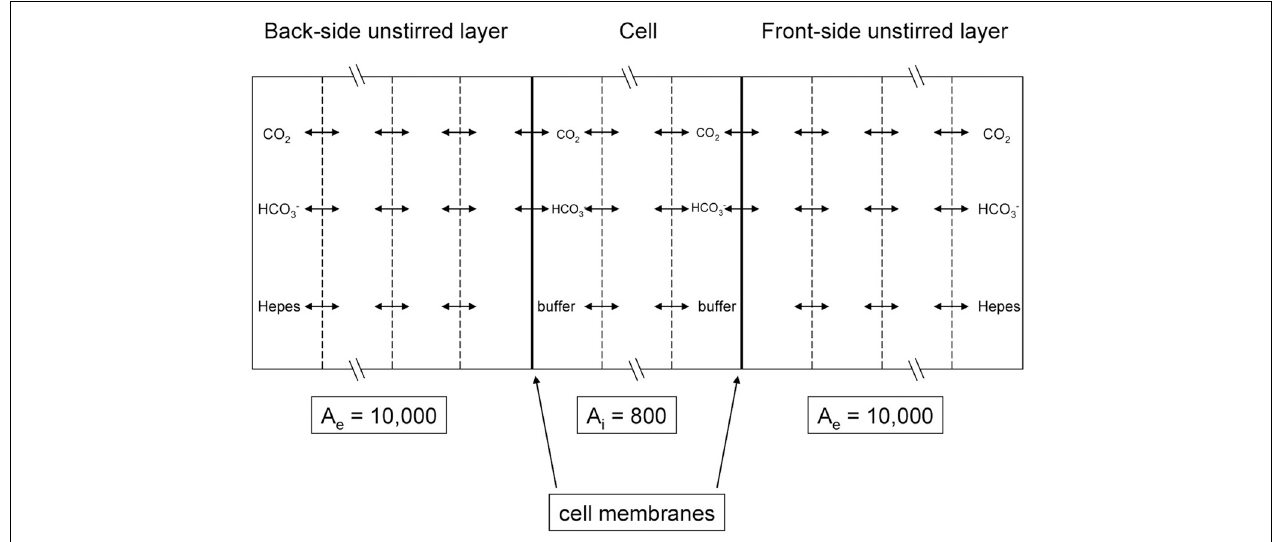
on the basal (front) side. The flow is determined by measuring the pH gradient with a pH microelectrode moving across the front-side unstirred layer and by inserting this pH gradient into Equation (6).